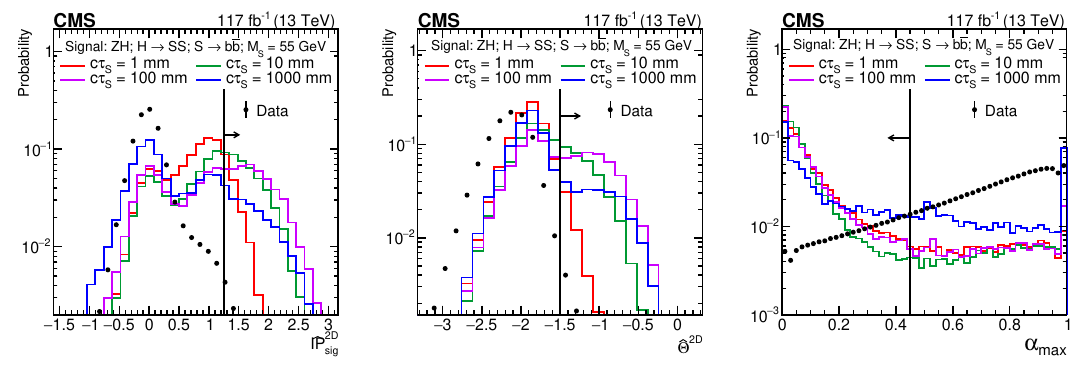
Figure 2 . Distributions of the three tagging variables for data and for four signal samples, where the decay lengths of the signal range from 1 to 1000 mm. The left figure displays the distributions for the ˆIP 2D tagging variable, while the center and right figures display the distributions for the ˆΘ 2D sig and α tagging variables, respectively. Overlaid on the figures is a line with an arrow pointing to max the region of where values of the variable are used to aid in distinguishing possible displaced jets from background